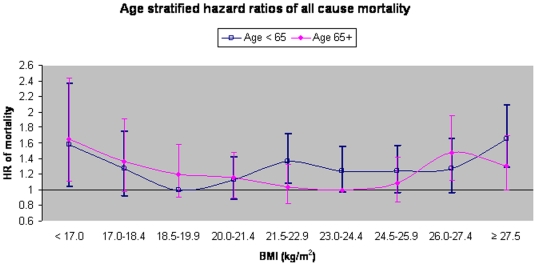
Age stratified hazard ratios of all-cause mortality according to BMI.Hazard ratios of all-cause mortality in participants aged less than 65 at baseline (N = 26,858, No. deaths = 1,344) and age 65+ (N = 3,680, No. deaths = 862). Figure encompasses all non-smokers who reported no prevalent disease and excludes deaths occurring within 5 years of baseline. Model is fully adjusted for age (continuous), sex, year of enrollment, dialect, education, dietary pattern score and physical activity. Points represent HR point estimate and error bars represent 95% confidence intervals. P value for interaction between age and BMI = 0.0001. Respective age & sex standardized mortality rates per 10,000 years follow up: Age<65 (48, 38, 28, 33, 40, 37, 39, 40, 51), Age 65+ (257, 219, 190, 194, 168, 161, 175, 226, 198).